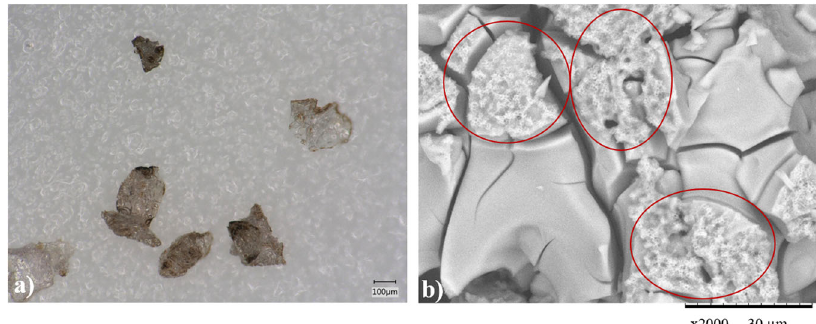
Fig. 3 Altered glass powders from the [VM100 + P. putida ] dissolution experiment. a Optical microscopy and b scanning electron microscopy. The red circles underline the presence of bio fi lm.